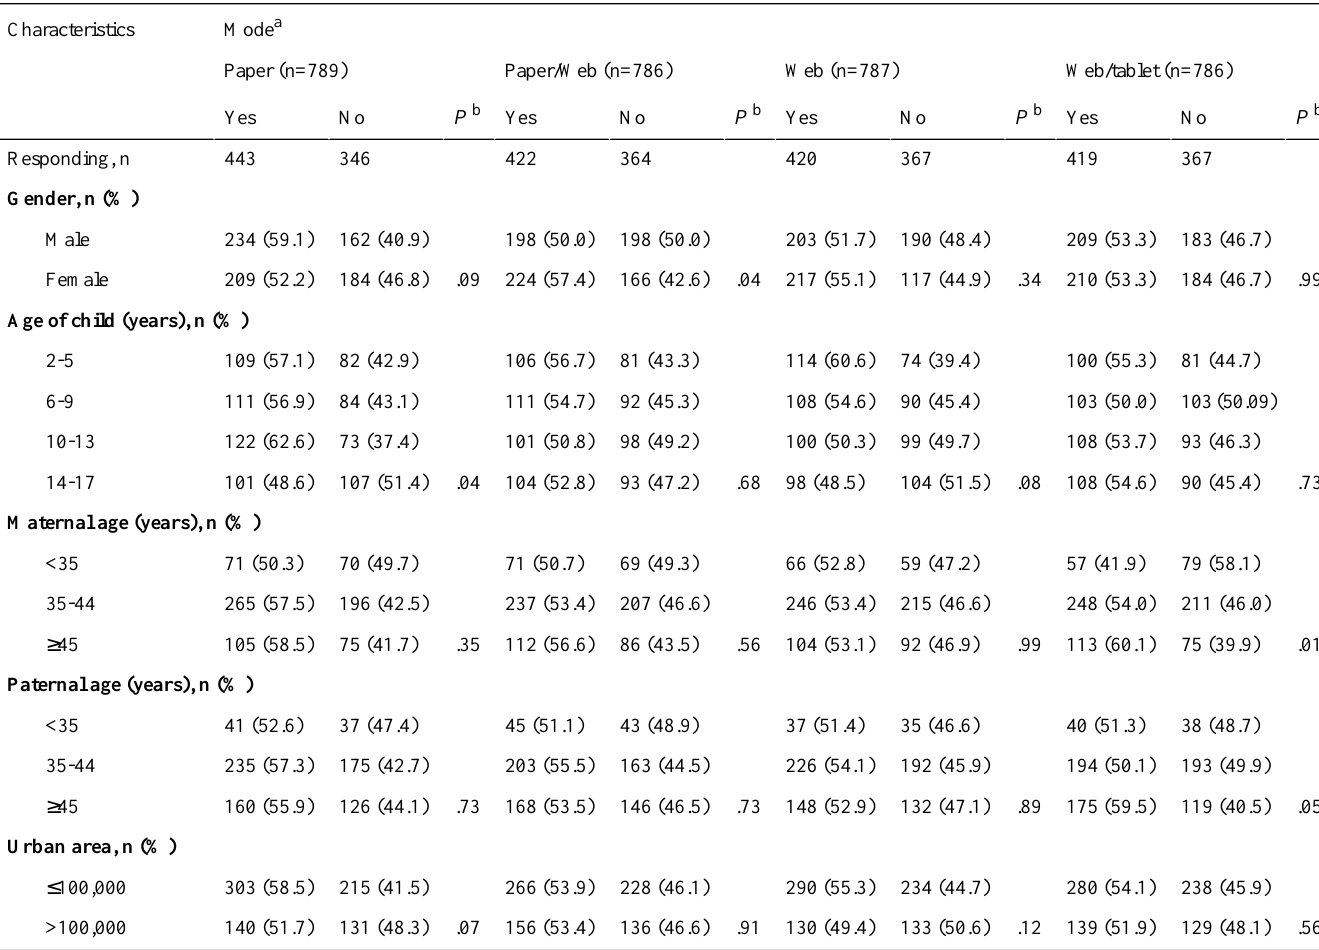
Table 1. Characteristics of the responders in the Danish part of the 2011 NordChild questionnaire survey. Mode a Characteristics